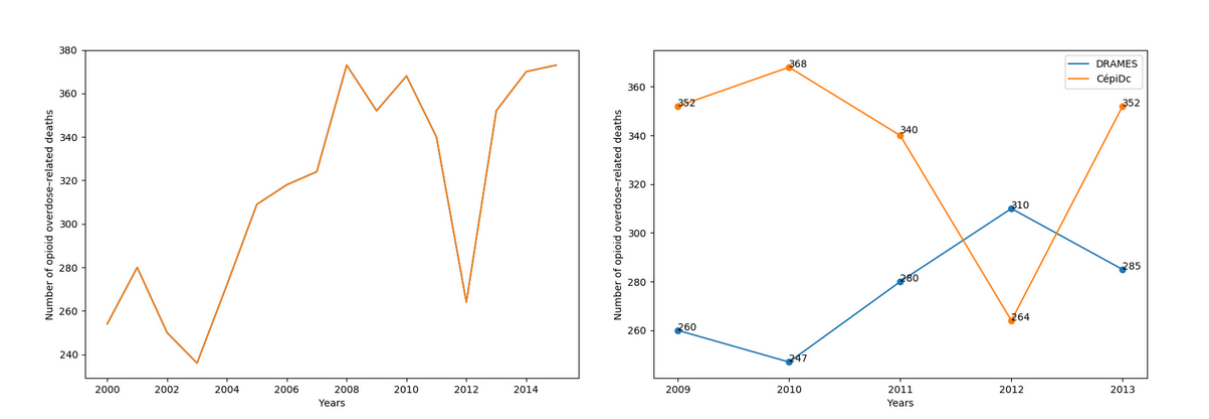
Figure 8. The left-hand plot shows the evolution of overdose-related deaths from 2000 to 2015 in France. The sudden decrease in 2012 appears anomalous. The right-hand plot shows the comparison with DRAMES (Décès en Relation avec l’Abus de Médicaments Et de Substances) data, a nonexhaustive, independent data source, which finds more deaths in 2012 than the exhaustive CépiDc (Centre d’épidémiologie sur les causes médicales de Décès) database.